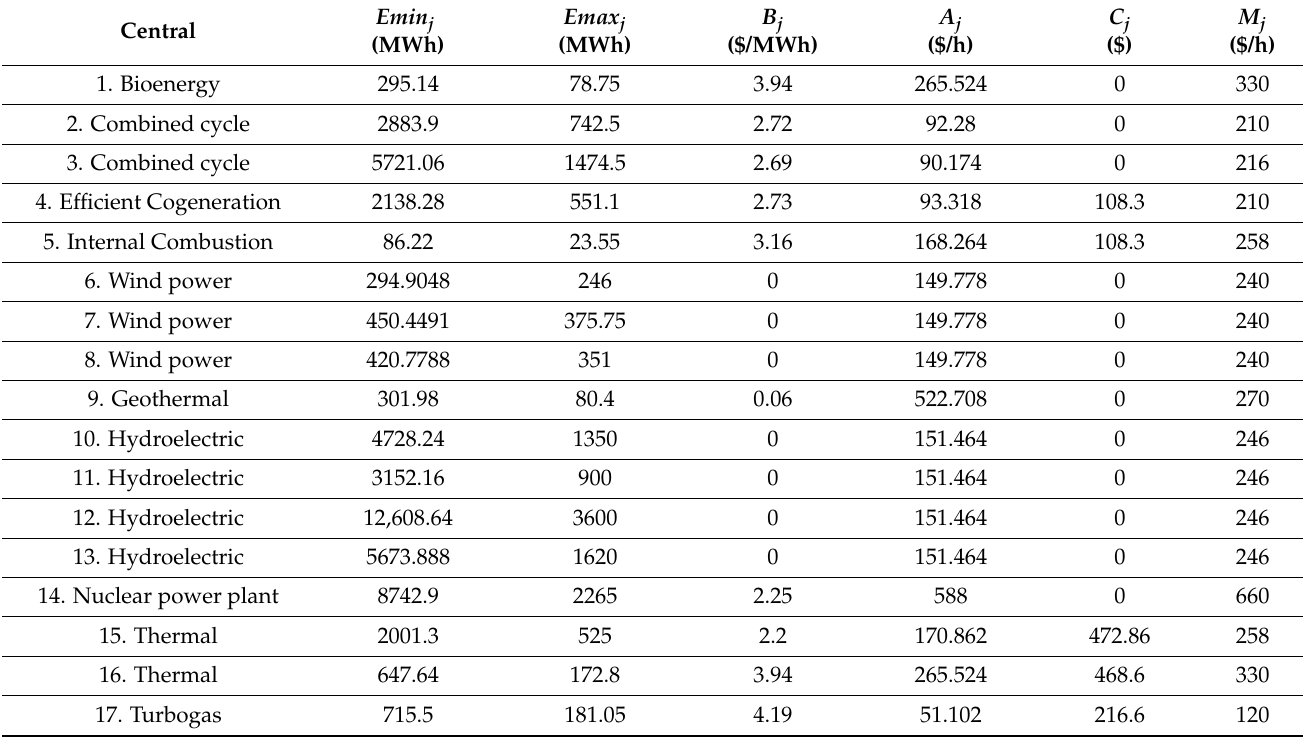
Table 2. Parameters of the Electric Power Plants